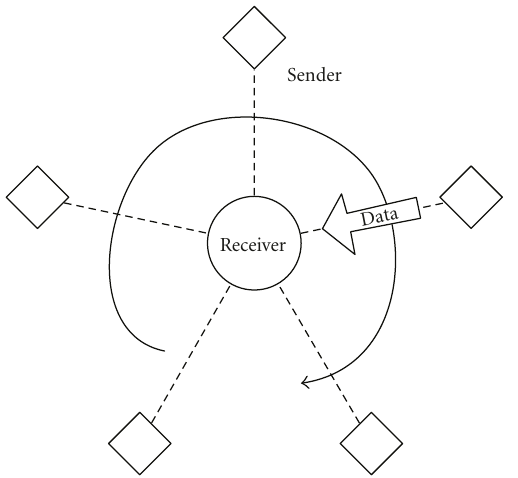
Figure 7: Round robin star network. The receiver mediates the round-robin data transfer, accepting data from the senders. Either sender or receiver can end the transfer.